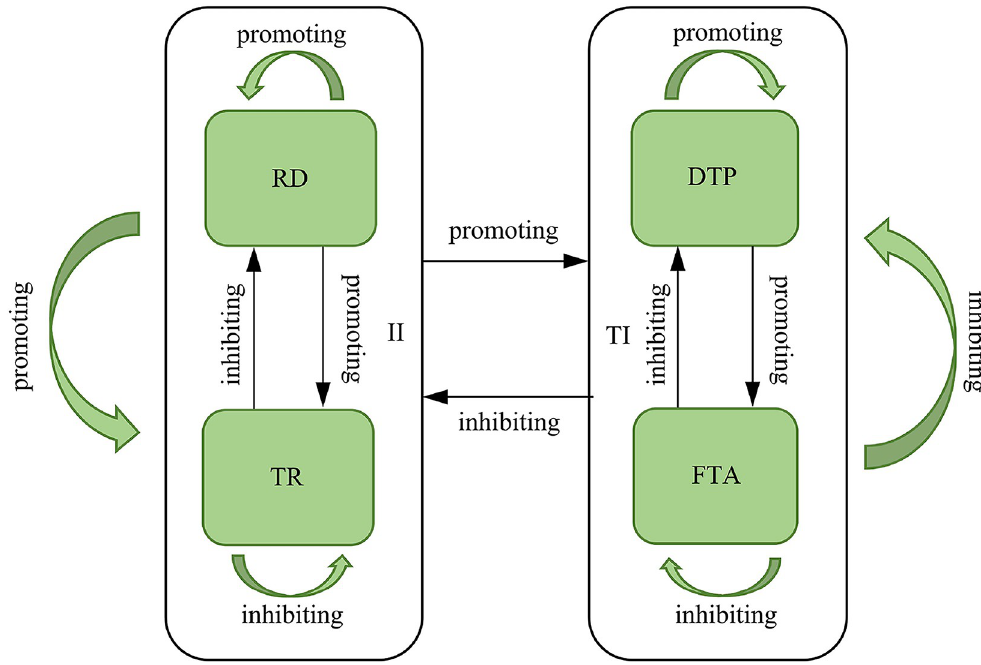
Fig 2. Ecological relationships of technology